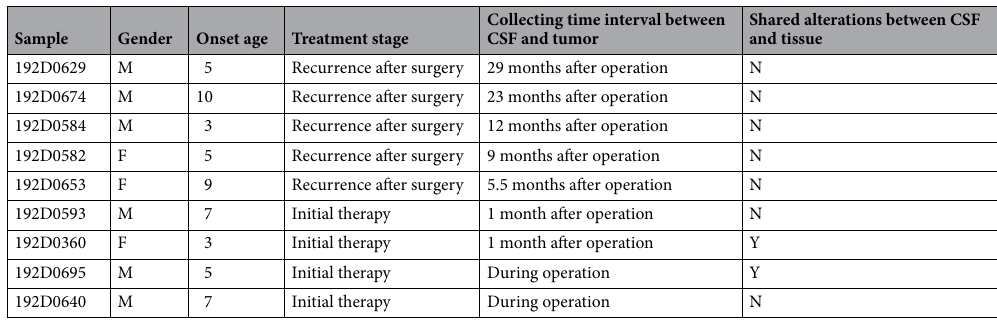
Table 4. The time interval for sample collection between CSF and tumor tissue. Y, with shared alterations; N, without shared alterations.